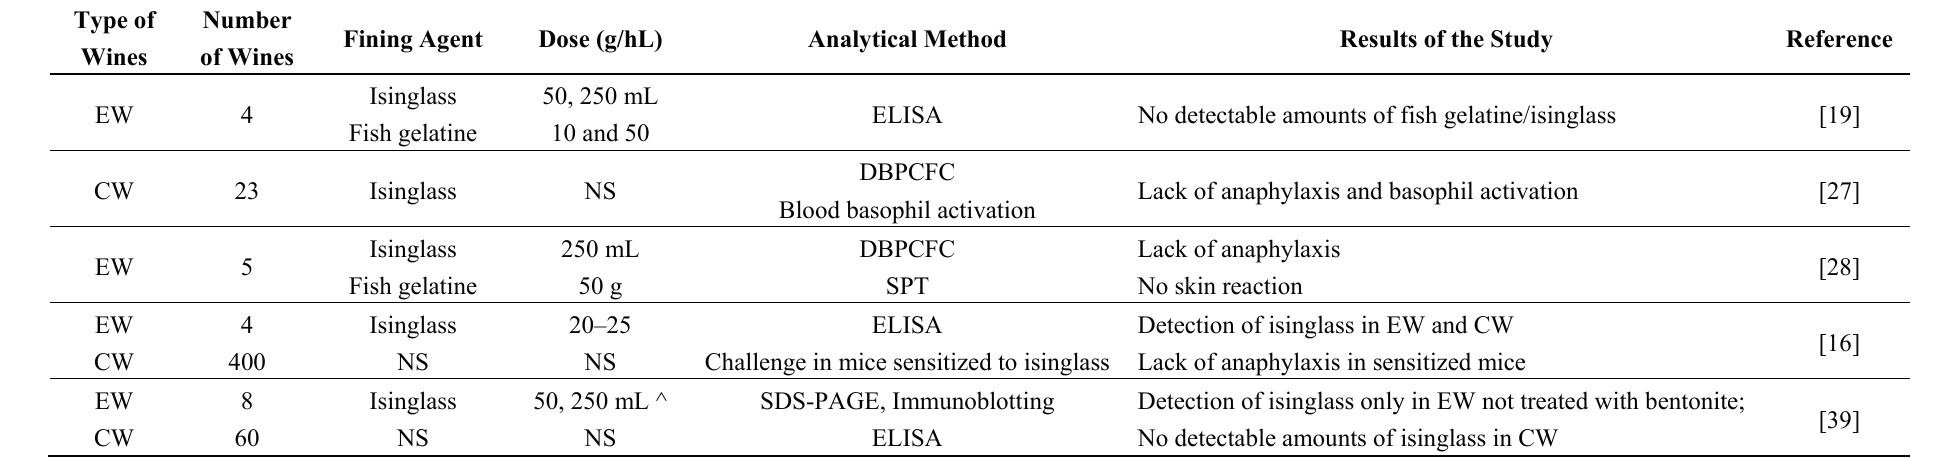
Table 6. Studies reporting data on allergenic residues in wines fined with isinglass/fish